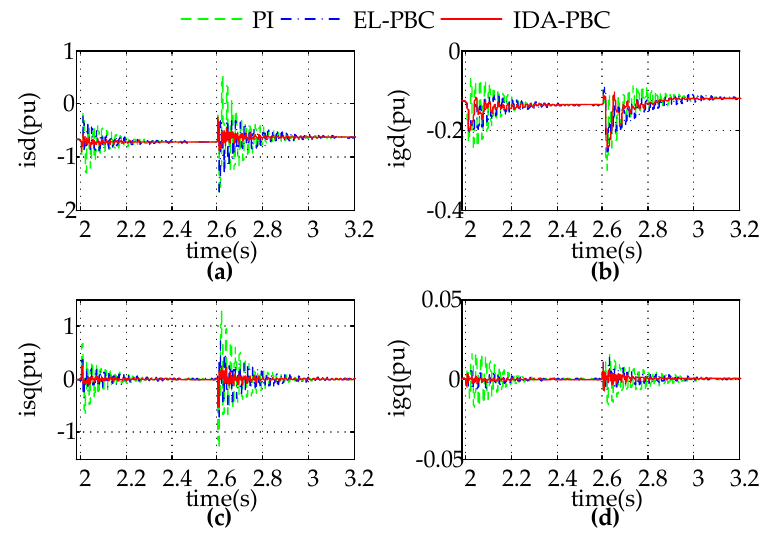
Figure 5. Suppressing the output current fluctuation: ( a ) Stator active current; ( b ) Grid-side converter active current; ( c ) Stator reactive current; ( d ) Grid-side converter reactive